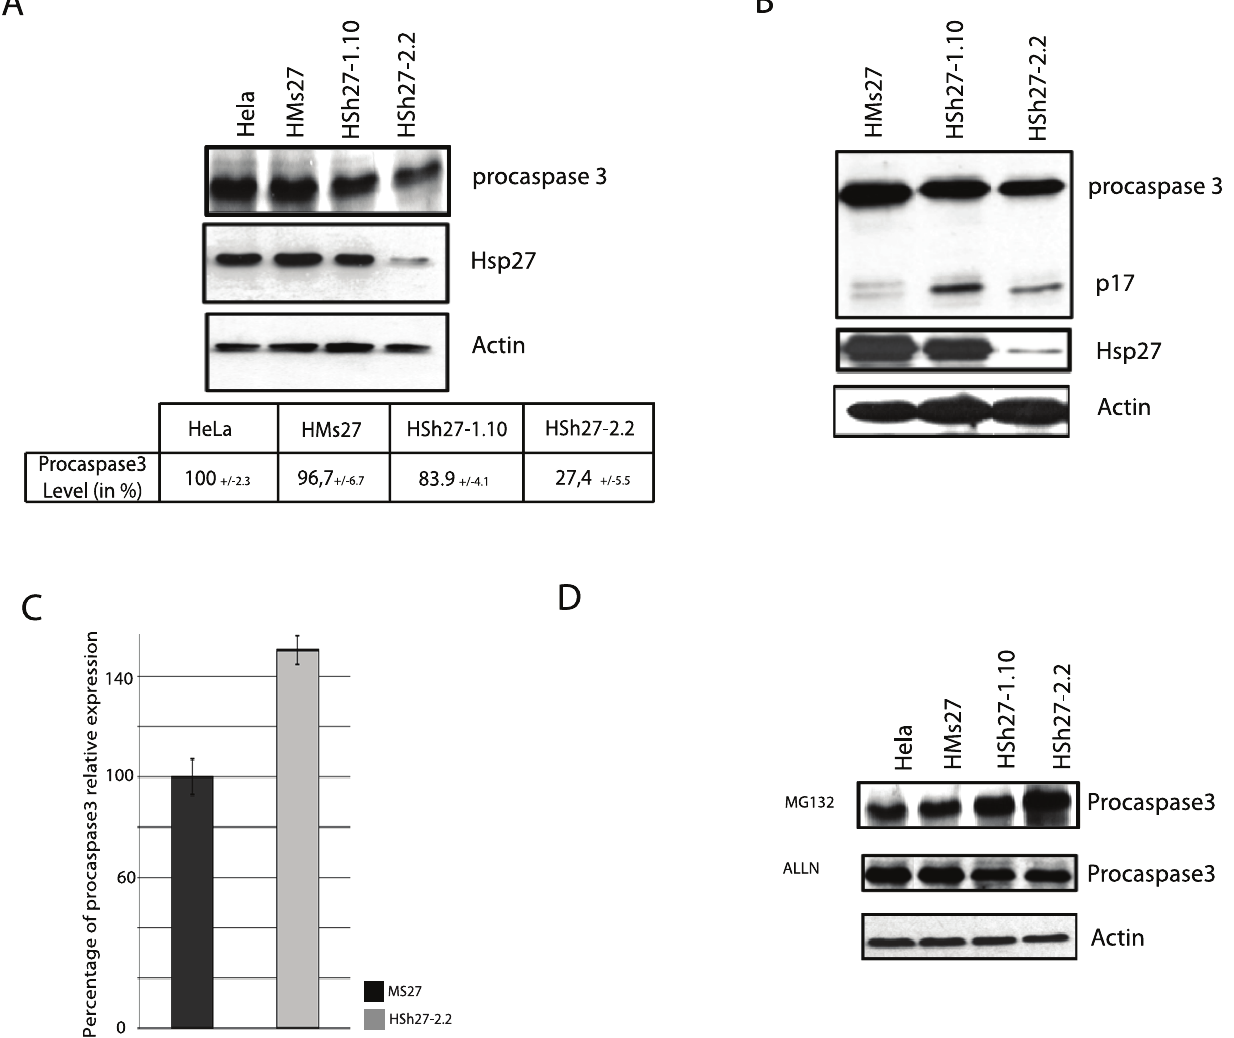
Figure 4. Knock out of Hsp27 induces procaspase-3 proteasomal degradation without modulating the expression of its gene. A , Total extracts of HeLa cell clones were analyzed in immunoblots incubated and revealed with caspase-3 antibody. Quantification of blots intensity was reported in a table. B , Each cell line was treated for 4 h with 0.25 m mol/L of staurosporine. Samples were analyzed in blot using anti caspase-3 antibody. C , Quantification of procaspase-3 gene relative expression by qPCR experiments. D , Effect of proteolytic inhibitors. Samples were collected after being treated with MG132 or ALLN, as described in Fig. 3. Levels of procaspase-3 were revealed by western blot analysis.